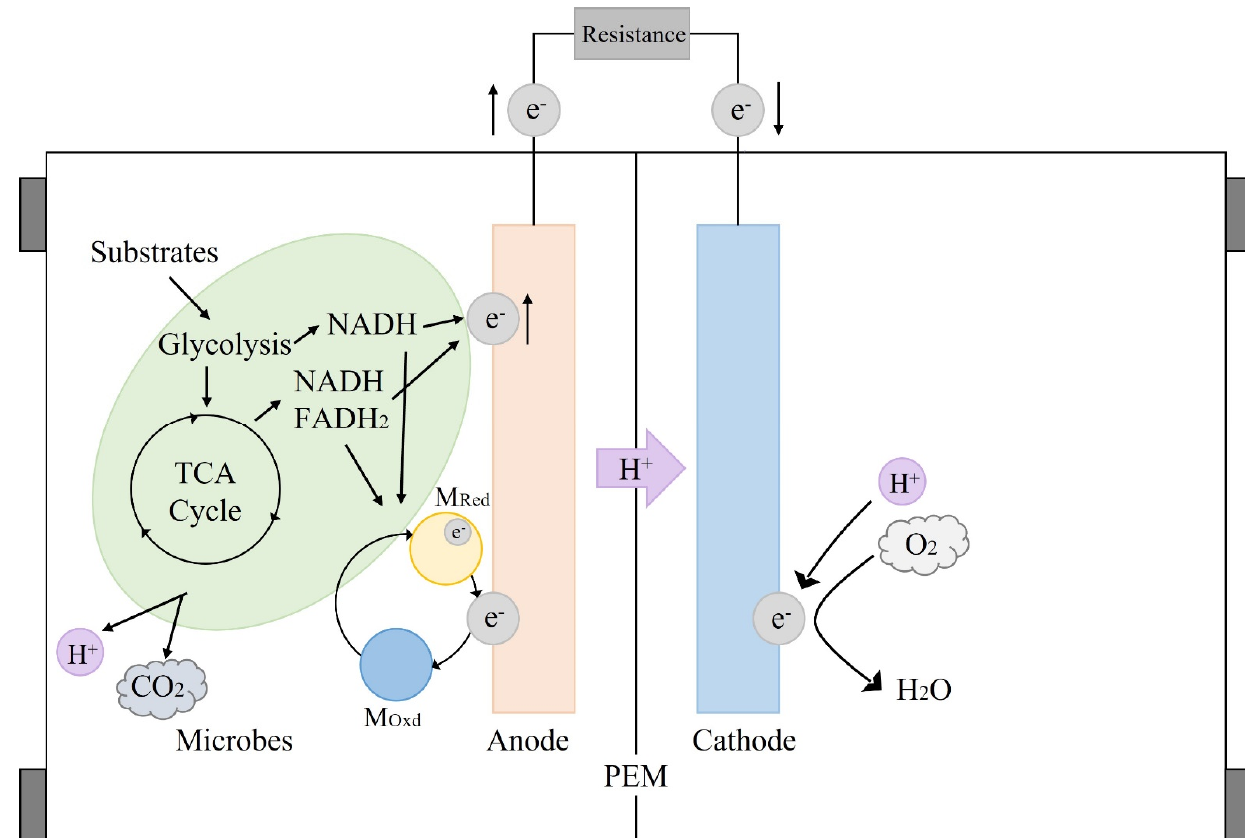
Figure 1. The operation mechanism of a dual-chamber MFC.